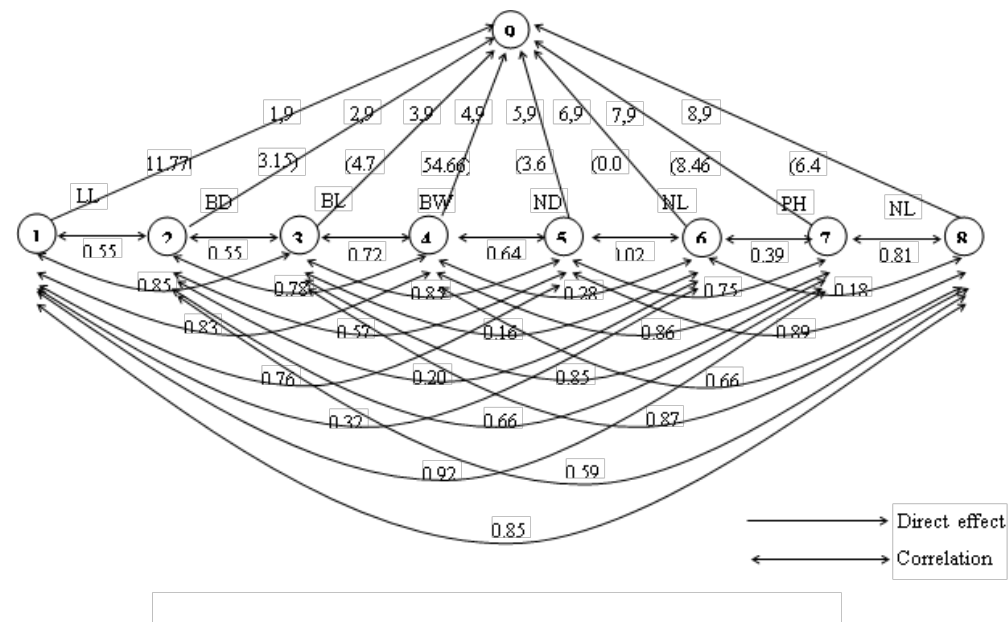
Figure 2 . Path diagram of different yield contributing factors on bulb yield at genotypic